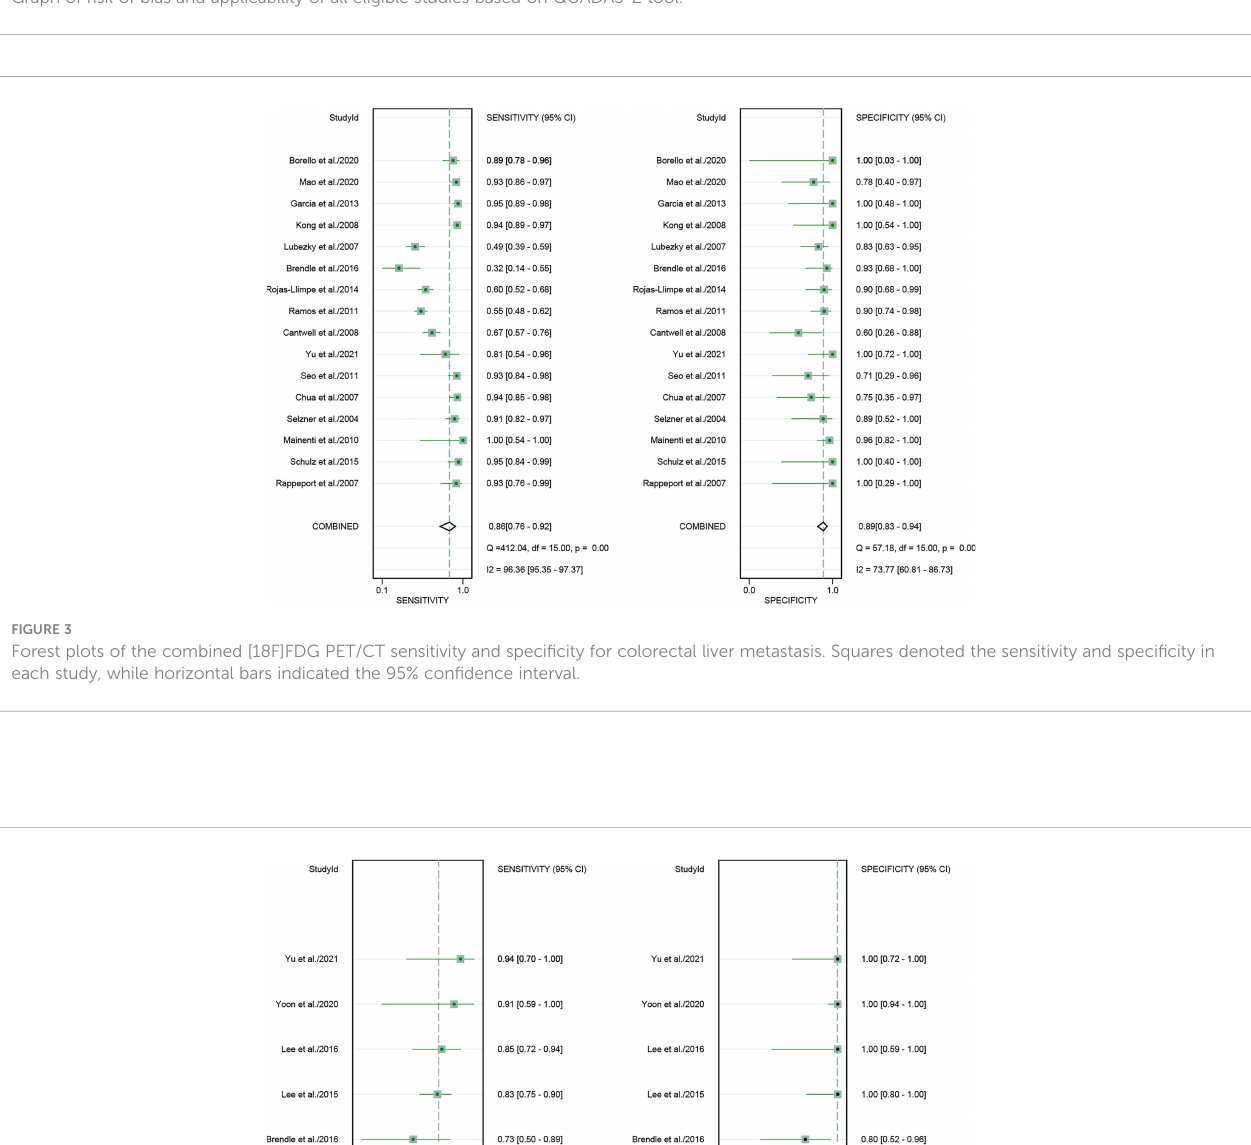
FIGURE 2 Graph of risk of bias and applicability of all eligible studies based on QUADAS-2 tool.